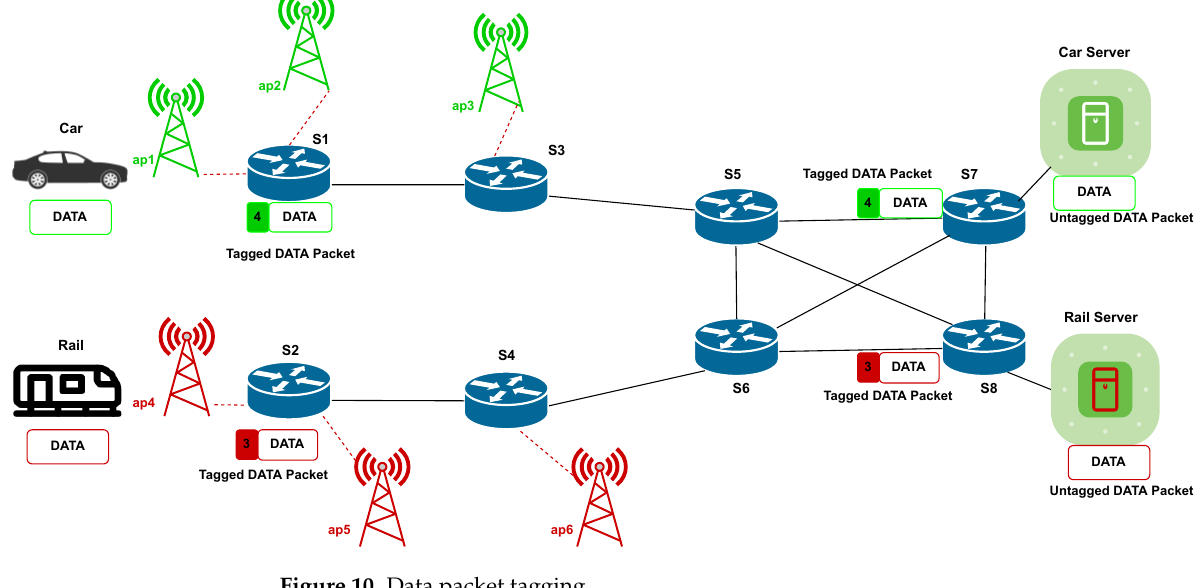
Figure 10. Data packet